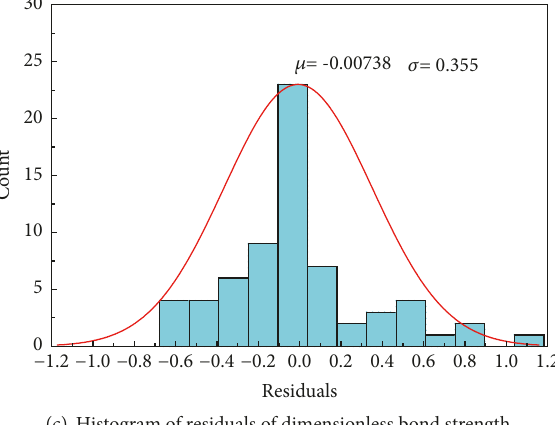
Figure 1: Dimensionless bond strength of pull-out specimens with plain rebar: (a) dimensionless bond strength versus corrosion level; (b) residuals versus corrosion level; (c) histogram of residuals of dimensionless bond